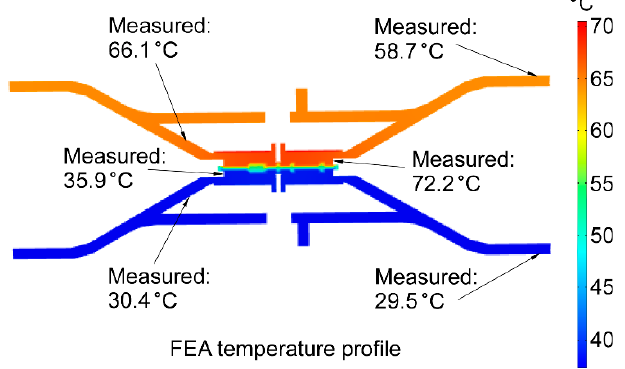
Figure 11. Comparison between measured temperature distribution and predicted profile from the FEA. At 2 W, the measured ∆ T across nanoporous membranes was ≈ 36.3 ◦ C, which was ≈ 14.3% higher than